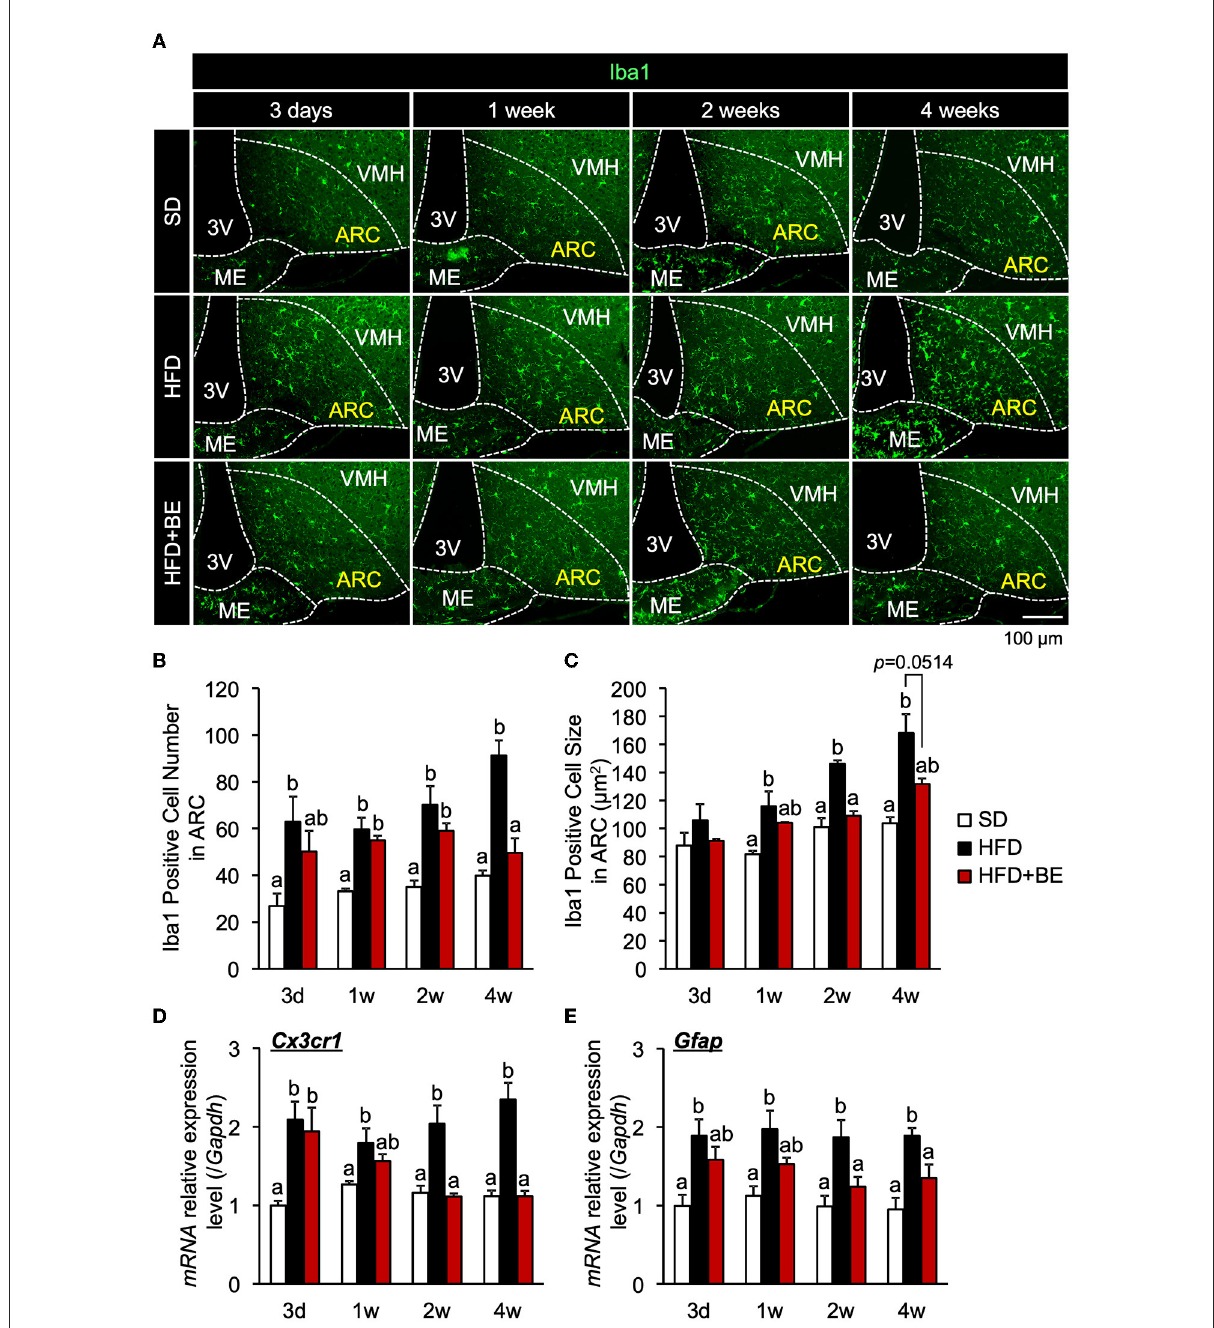
FIGURE1 Effects of BE on HFD-induced hypothalamic gliosis in mice. (A) Sections of the mediobasal hypothalamus (MBH) of mice (10- µ m-thick) were immunofluorescence-stained for Iba1 on Day 3 (3d), Week 1 (1w), Week 2 (2w), and Week 4 (4w) of the feedings. The third ventricle (3V), median eminence (ME), hypothalamic arcuate nucleus (ARC), and ventromedial hypothalamic nucleus (VMH) of the left side of the brain of mice in each group are shown. (B,C) Number and size of Iba1-positive cells, respectively, in the ARC. The cell number and size on sections through the ARC of the left and right hemisphere of the brain were measured and mean values calculated. n = 3. (D,E) Quantitative RT-PCR analysis showing high mRNA expression of gliosis marker, (D) CX3C chemokine receptor 1 ( Cx3cr1 ) and (E) Glial fibrillary acidic protein ( Gfap ), in the whole hypothalamus of mice on Day 3, Week 1, Week 2, and Week 4 of the study. Data shown are mean ± SE ( n = 5). Different letters represent significant differences among the three groups at each experimental period by Tukey-Kramer honestly significant difference test ( p <